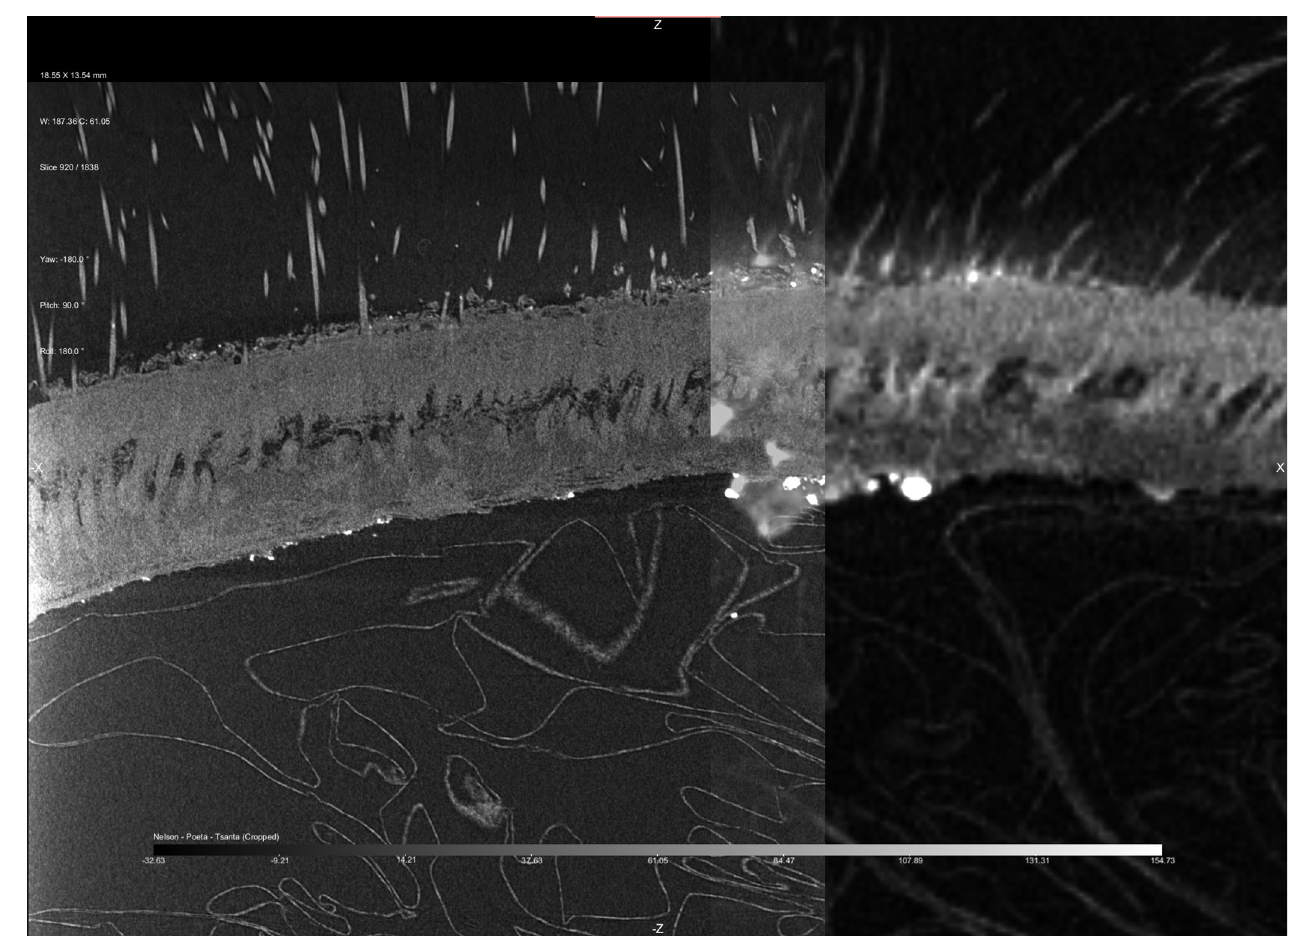
Fig 9. Slice of the co-registered micro-CT volumes at 14 μ m (left) and 75 μ m scan (right).